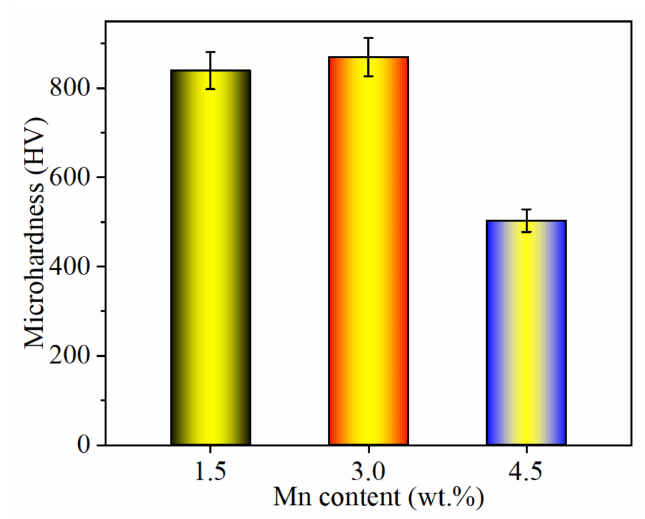
Figure 8. Microhardness—three samples.